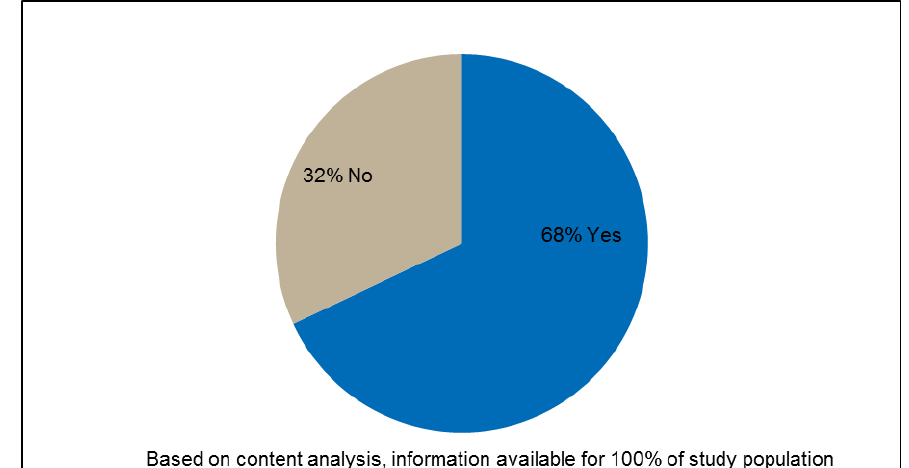
Figure 5: Number of Chinese Blogs with Advertisements